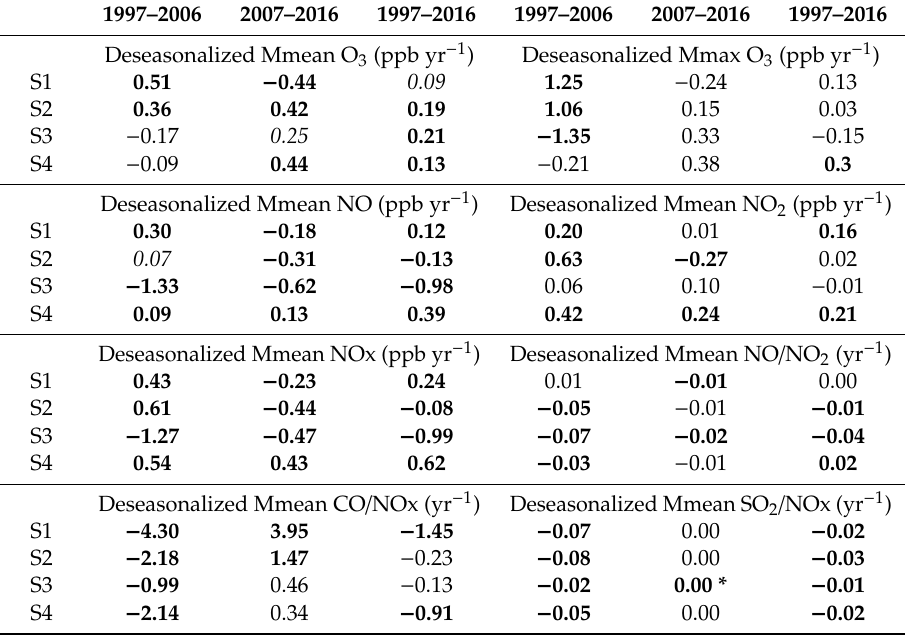
Table 2. Deseasonalized trends for monthly mean (Mmean) pollutant concentrations and monthly mean of daily maximum O 3 (Mmax O 3 )